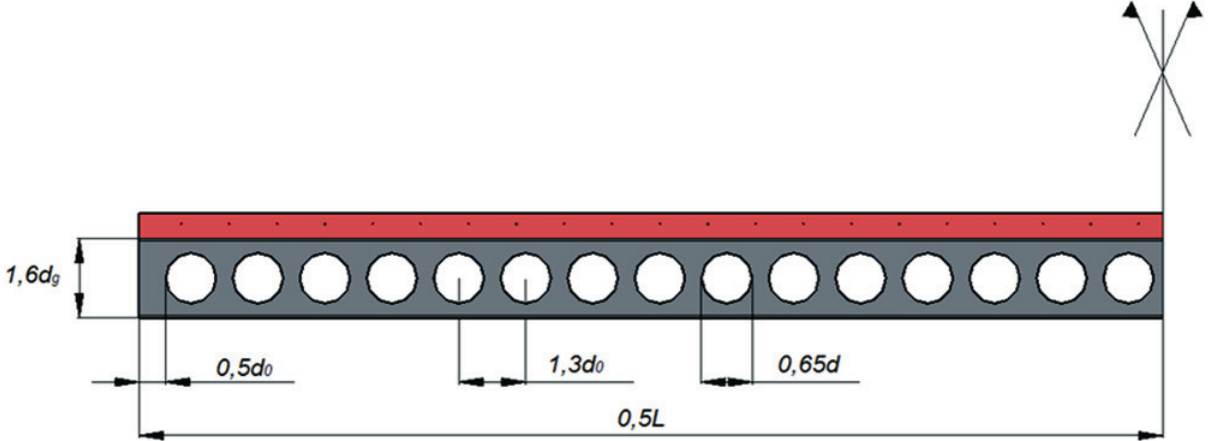
Modelo padrão – vista